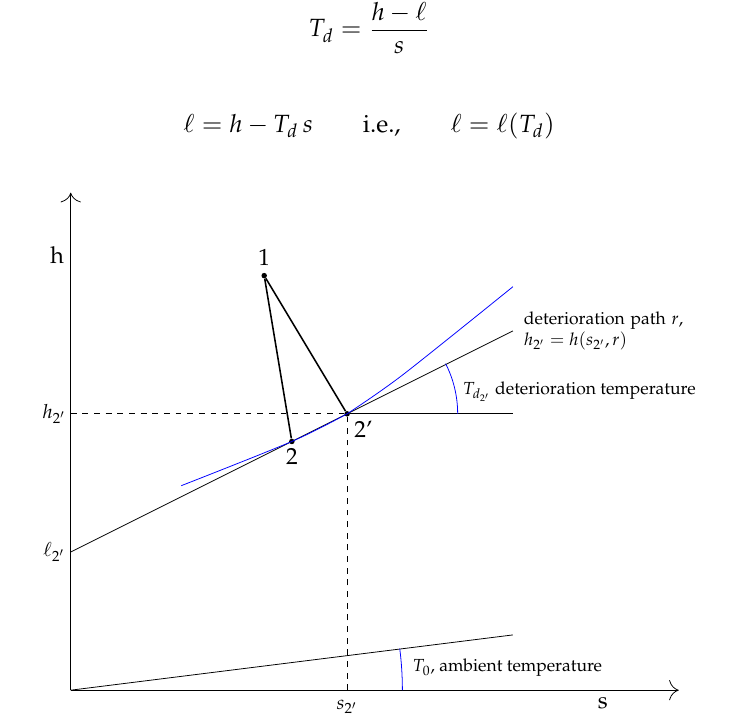
Figure 9. Geometric representation of relative free energy and deterioration